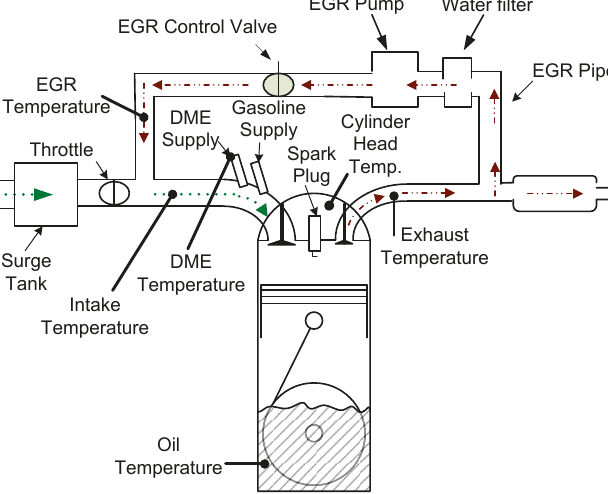
Figure 2. Experimental setup for the proposed dual-fuel HCCI engine with external EGR.